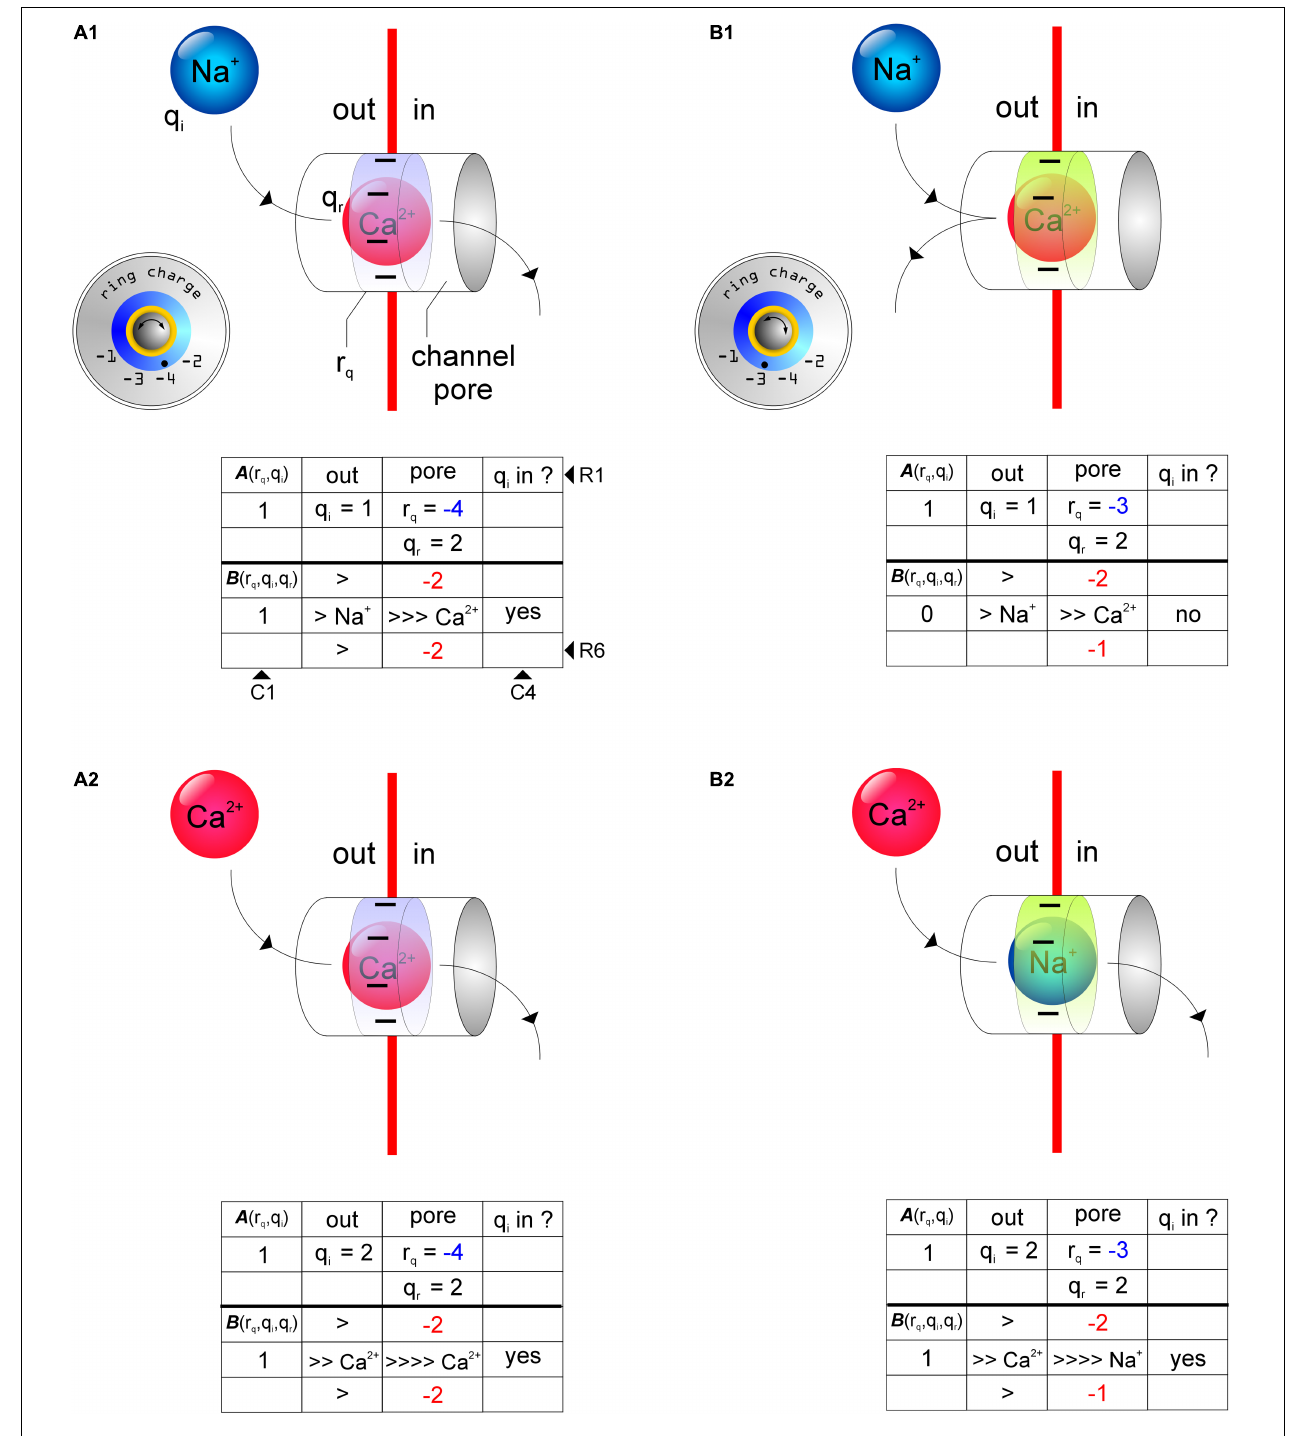
FIGURE 3 | Schematics of test configurations depicting the use of the charge permeability equation (1) to predict selectivity and permeability of cations in receptor channels as a function of total ring charge of their respective selectivity filters ( r q , ring charge dials, insets ). (A 1 ,A 2 ) Permeability of Na + (q i , A 1 ) and Ca 2 + (q i , A 2 ) in a receptor channel with r q = –4 when occupied by Ca 2 + (q r , A 1 , A 2 ) . (B 1 , B 2 ) Permeability of Na + ( q i , B 1 ) and Ca 2 + ( q i , B 2 ) in a receptor channel with r q = –3 when occupied by Ca 2 + ( q r , B 1 ) and Na + ( q r , B 2 ). Note how Na + can displace Ca 2 + in a channel with r q = –4 but not r q = –3 (A 1 ,B 1 ) and that Ca 2 + can displace itself or Na + from the pore of a channel with r q = –4 or –3 (A 2 ,B 2 ) . The tables underneath the schematics depict the working underlying computation of the terms A (cid:0) r q , q i (cid:1) (R2C1; R, row ; C, column ) and B ( r q , q i , q r ) (R5C1) associated with the charge permeability equation. > , electromotive force on q r exerted by q i (R4-6C2, R5C3); numbers colored red (R4C3, R6C3), total ring charge r q ( blue , R2C3) distributed around q r (R5C3).